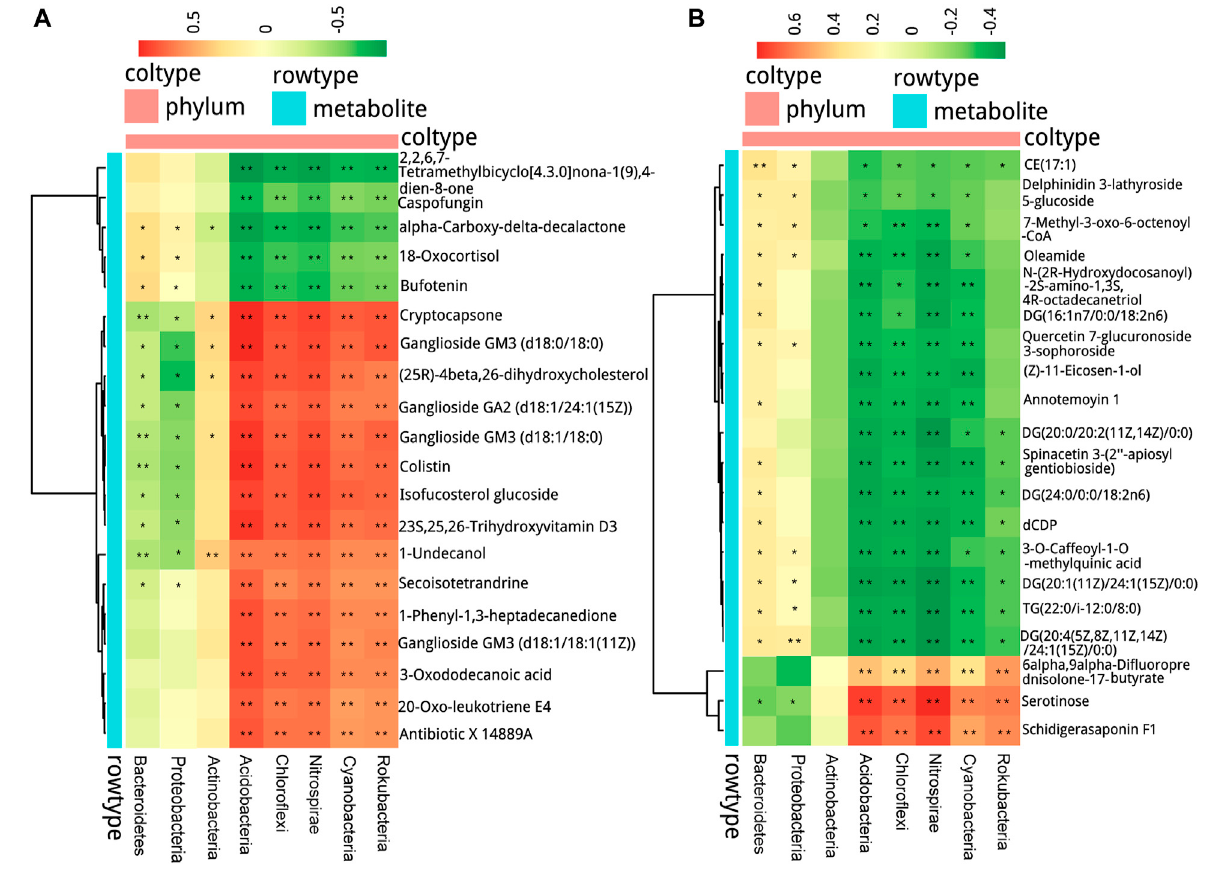
Frontiers in Pharmacology |